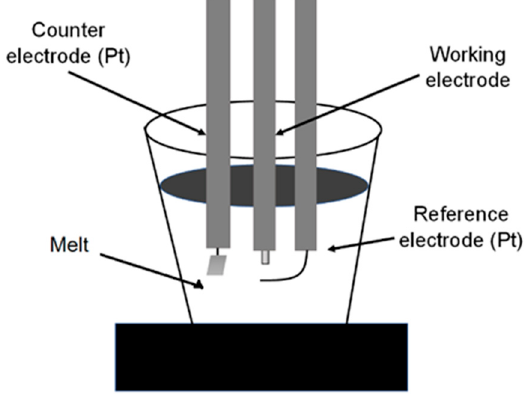
Figure 1. Set-up arrangement for the electrochemical tests.